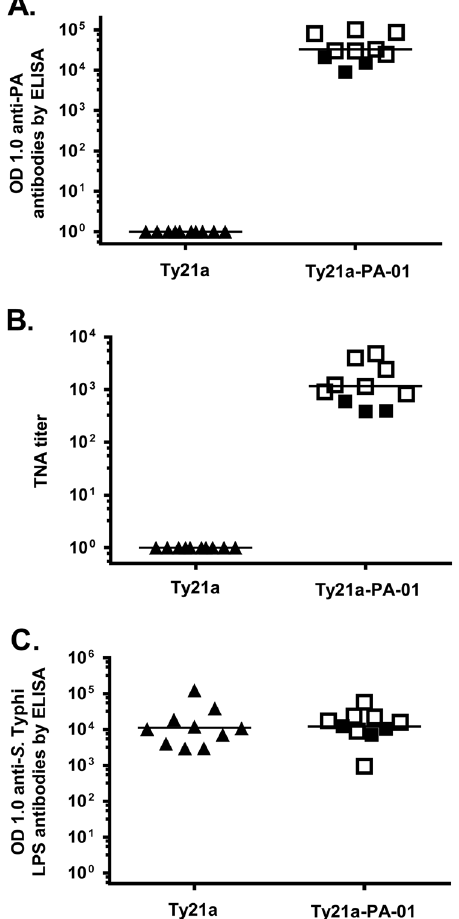
Fig. 2 Antibodies in rabbits immunized with Ty21a-PA-01. Rabbits were vaccinated with 1 × 10 9 CFU of Ty21a ( triangles ) or Ty21a-PA-01 ( squares ) by IP injection at 4-week intervals. Sera collected 2 weeks after dose 4 were assayed for anti-PA IgG by ELISA ( a ), anthrax toxin neutralization activity (TNA) ( b ), and anti- S . Typhi LPS IgG by ELISA ( c ). Filled symbols represent rabbits that were not protected in the spore challenge study and open symbols represent those that were protected (see Fig. 4). Geometric mean of each group is shown as a horizontal line. Anti-PA responses by ELISA and TNA responses, but not anti- S . Typhi LPS responses by ELISA, were signi fi cantly higher in the immunized as compared to control rabbits ( p = 6.39 × 10 − 5 , 6.39 × 10 − 5 , and 0.53, respectively, by Mann – Whitney U Test). The geometric mean OD 1.0 of anti-PA antibodies by ELISA was 47,268 for the seven protected rabbits as compared to 14,107 for the three unprotected rabbits ( p = 0.0167, Mann – Whitney U test). Likewise, the geometric mean TNA titer was 1,741 for the protected rabbits and 447 for the unprotected animals ( p = 0.0167)